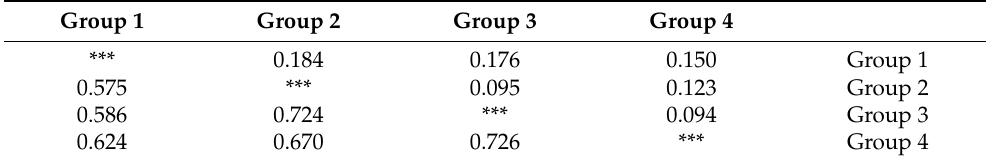
Table 8. Pairwise estimate of F ST and N m among four groups of the populations of Meloidogyne ja- vanica from Iran.